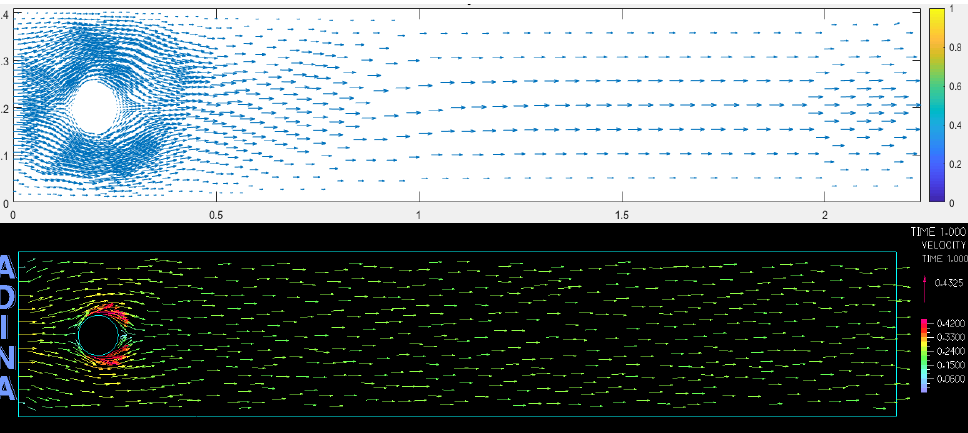
Figure 6. Velocity vector solution by P 1 − Bubble / P 1 ( above ) and velocity vector solution computed by the ADINA system ( below ) with α 1 = 10 − 4 , α 2 =